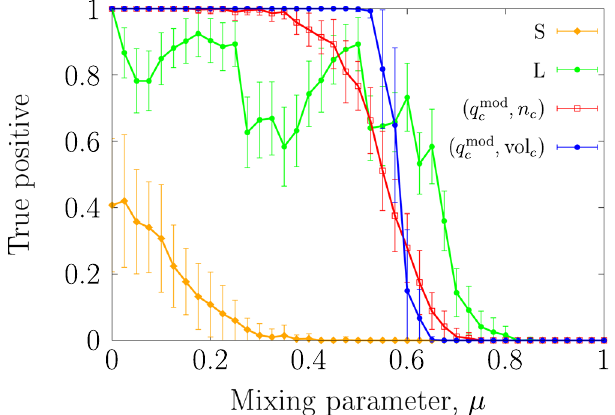
Figure 2. True positive rate for the statistical tests applied to the networks generated by the LFR model. Legends S, L, q indicate the S–test, the L–test, the q –test, respectively. The error bars indicate the ± 1 standard deviation.